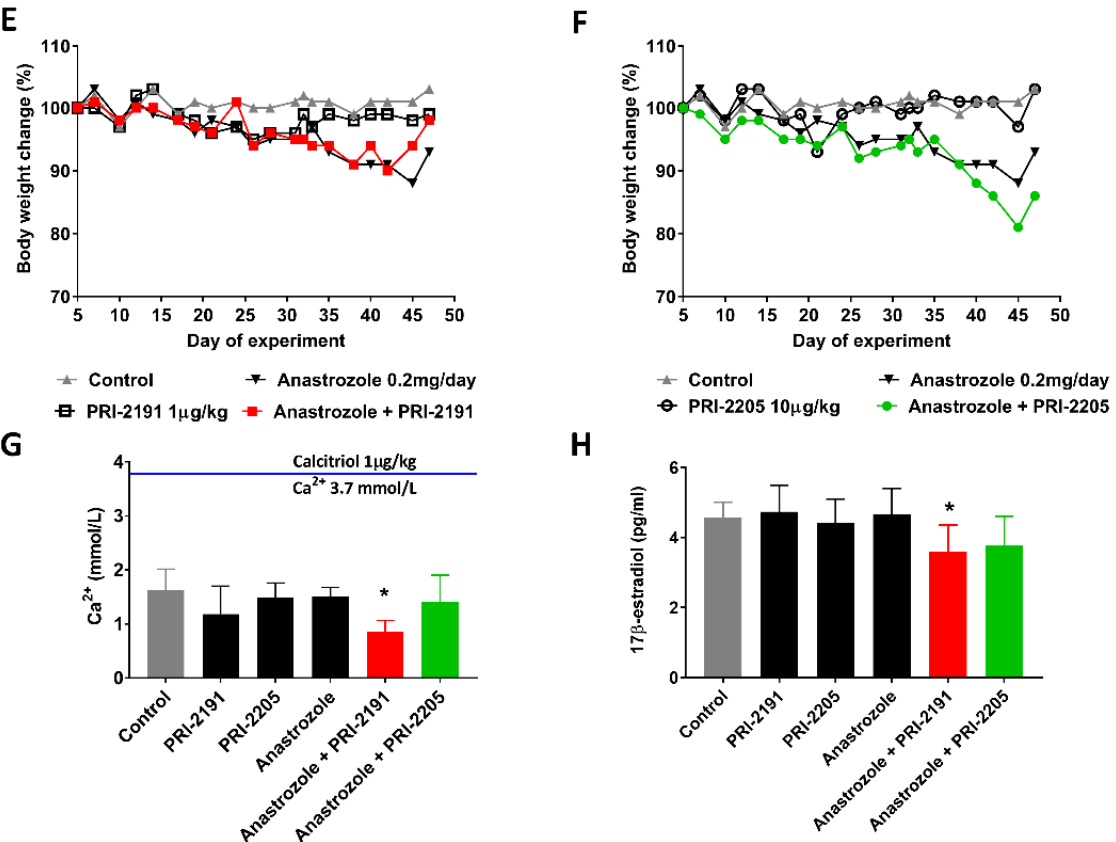
Figure 7. The antitumor effect of vitamin D analogs when used alone or in combination with anastrozole in MCF-7 tumor-bearing mice. Five days after tumor inoculation (tumor volume was measured), the mice received subcutaneous (s.c.) injections of PRI-2191 (1 µ g/kg body weight (b.w.) in each injection) or PRI-2205 (10 µ g/kg b.w. in each injection) and/or anastrozole (200 µ g/mouse in each injection). PRI-2191 and PRI-2205 were administered three times a week, and the total dose was 17 µ g/kg and 170 µ g/kg respectively. Anastrozole was administered five times a week, at the total dose of 5.2 mg/mouse. ( A , B ) tumor growth kinetics after treatment with PRI-2191 ( A ) or PRI-2205 ( B ) alone or combined with anastrozole. ( C , D ) present the tumor growth inhibition (TGI) in % calculated according to the formula given in this article. ( C ) Red bars indicate TGI for combined PRI-2191 and anastrozole treatment. (cid:3) —PRI-2191 alone, (cid:72) —anastrozole alone treatment. ( D ) Green bars indicate TGI for combined PRI-2205 and anastrozole treatment, —PRI-2205 alone, (cid:72) —anastrozole alone treatment. ( E , F ) body weight (b.w.) changes during the treatment in all the experimental groups. ( G ) (cid:35) The serum calcium level at the end of the experiment. The serum calcium levels were measured at the end of the experiment by using a Roche Diagnostic Kit. Data presented in mmol/L are expressed as mean with SD for each group, except for calcitriol, which was administered subcutaneously to a single NOD/SCID mouse at the dose of 1 µ g/kg b.w. (sacrificed after 48 h). To demonstrated the safety of using both vitamin D analogs in comparison to calcitriol, the serum calcium level was evaluated in one mouse. ( H ) The 17 β -estradiol serum levels after treatment. The 17- β estradiol levels were measured using the IBL ELISA kit, which is used for in vitro diagnostic quantitative determination of 17 β -estradiol. Statistical analysis was performed using Kruskal–Wallis ANOVA, For calcium and 17 β -estradiol level in serum * p < 0.05 compared to the control